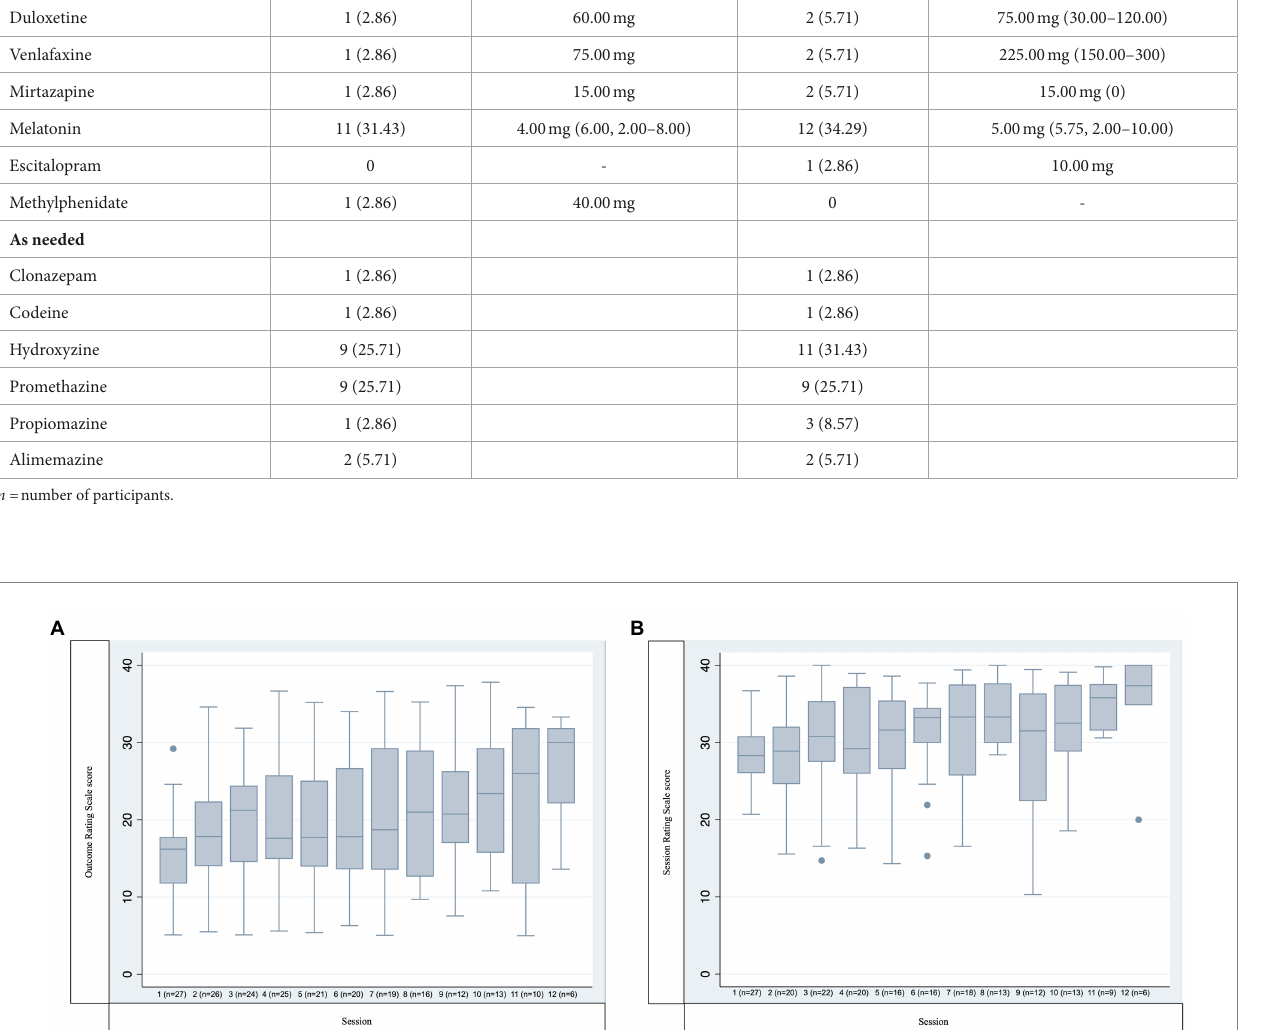
Prescribed at Dose at T1, Median (IQR, T1, n (%) range)